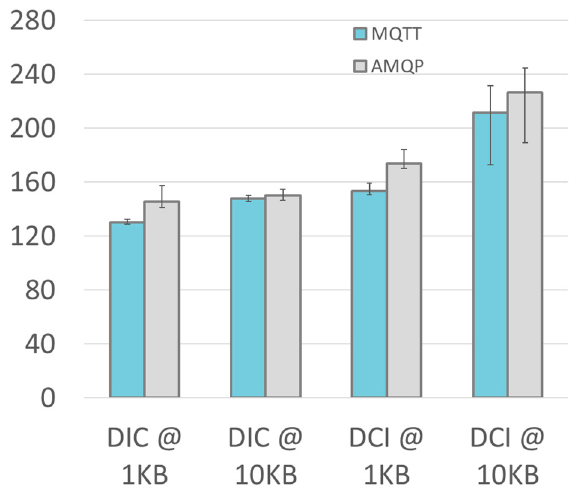
Figure 11. Bar graph of the DIC and DCI performance metrics with cloud server. The whiskers go from the 5 percentile up the 95 percentile.